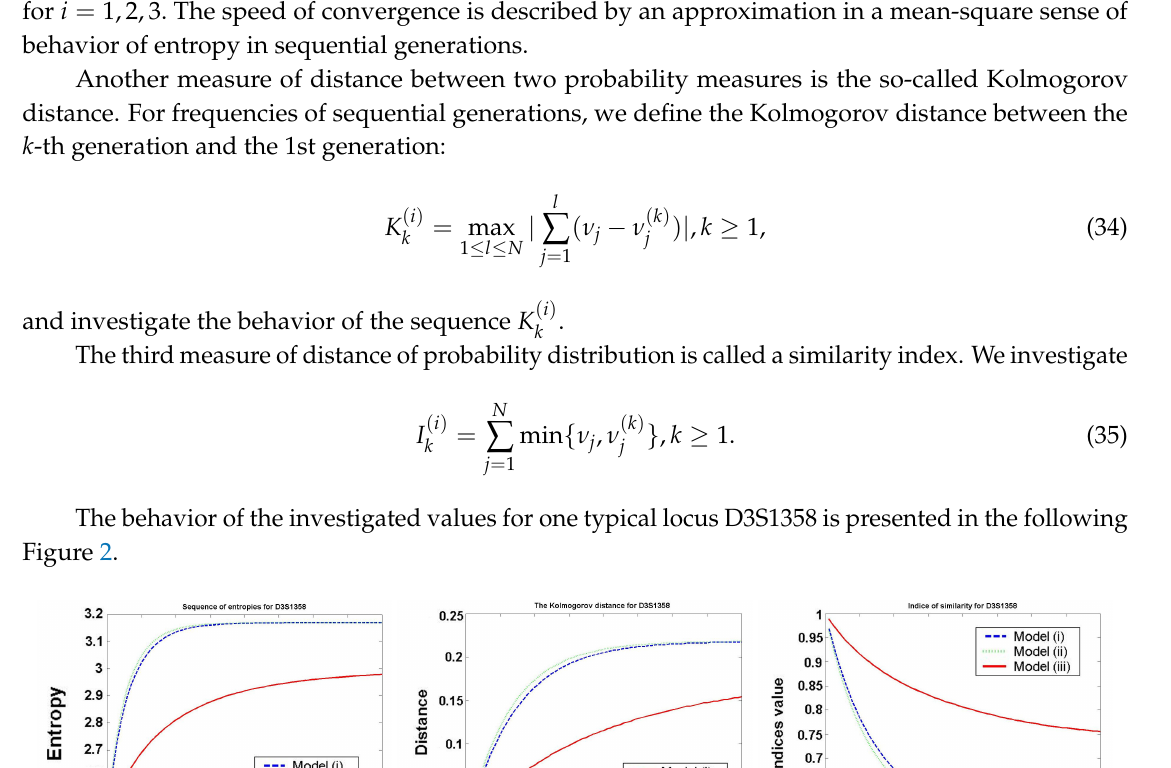
( i ) , and similarity index I k